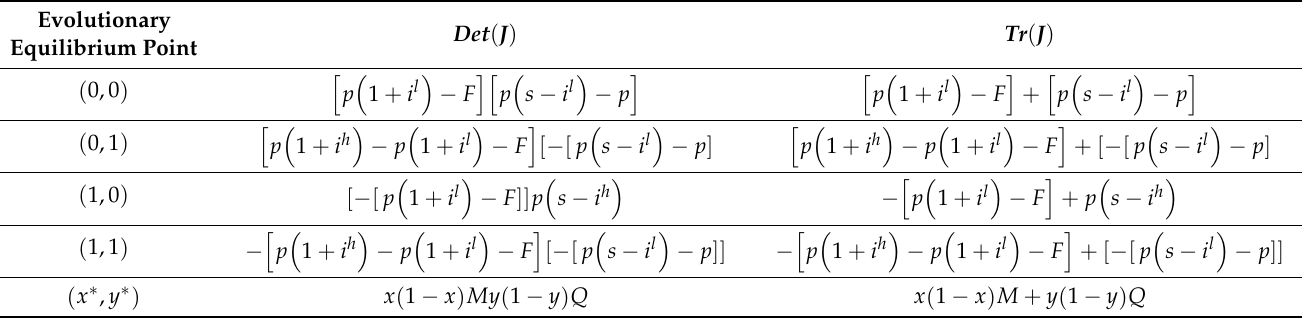
Table 3. The value and trace of the Jacobian matrix at each evolutionary equilibrium point for inactive online lending platforms.